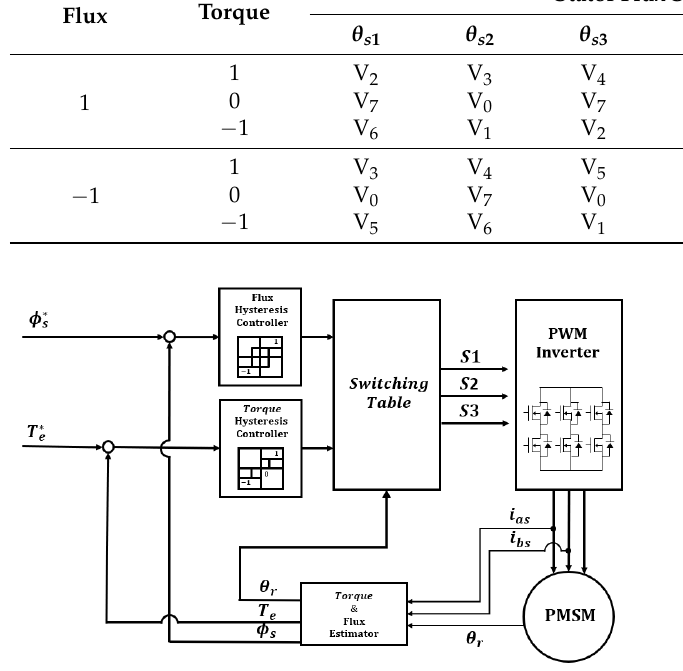
Figure 1. Block diagram of Conventional DTC control technique .